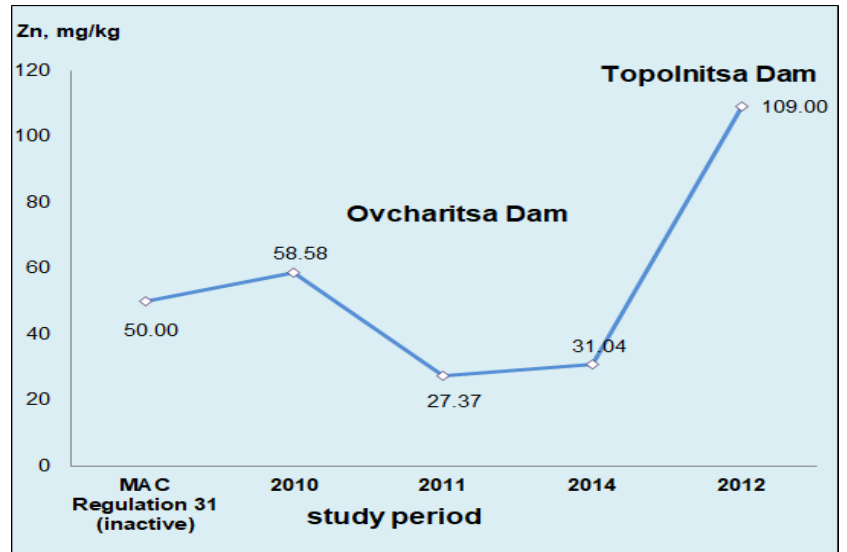
Figure 2. Content of Zn in liver samples of common carp inhabiting Ovcharitsa Dam in the period of 2010–2014 [4], as well as Topolnitsa Dam in 2012